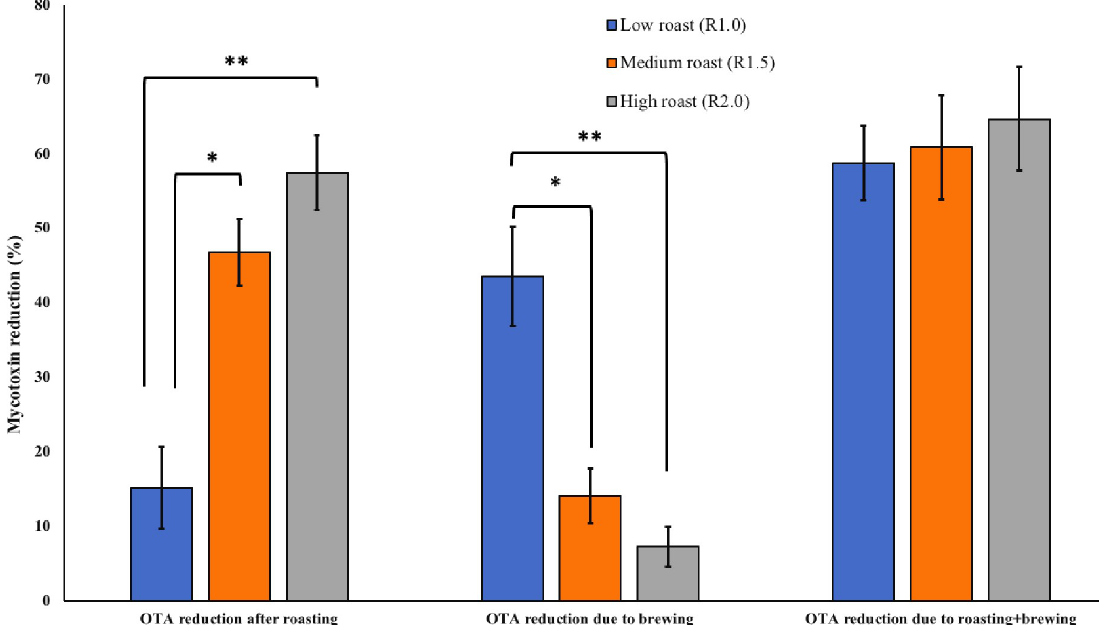
Fig 2. Effect of traditional roasting and brewing on OTA reduction (%) in naturally contaminated coffee beans. Roasting OTA contaminated coffee beans at traditionally low, medium and high methods resulted in 15.17% (0.61 μ g/kg), 46.78% (2.99 μ g/kg) and 57.43% (3.82 μ g/kg) reduction in mycotoxin contents, respectively. Brewing of OTA coffee samples already roasted at low, medium and high schemes resulted in further 43.57%, 14.11% and 7.28% reduction in mycotoxin, respectively.